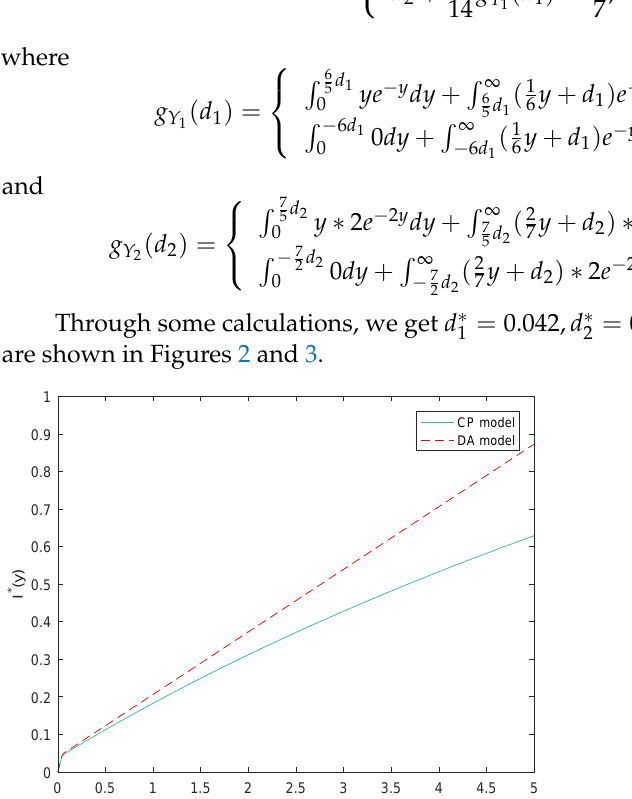
Figure 2. The optimal strategy of the first class I ∗